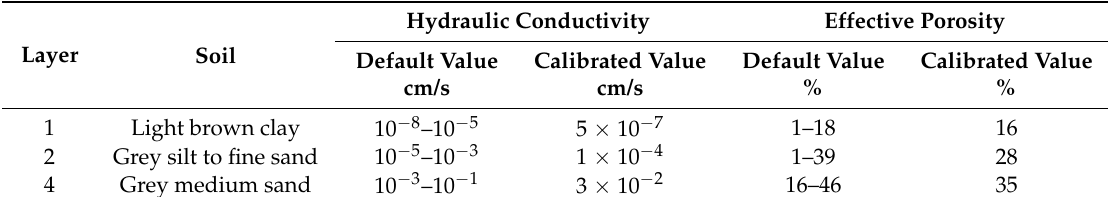
Table 3. Calibration of the Processing Modflow model parameters.